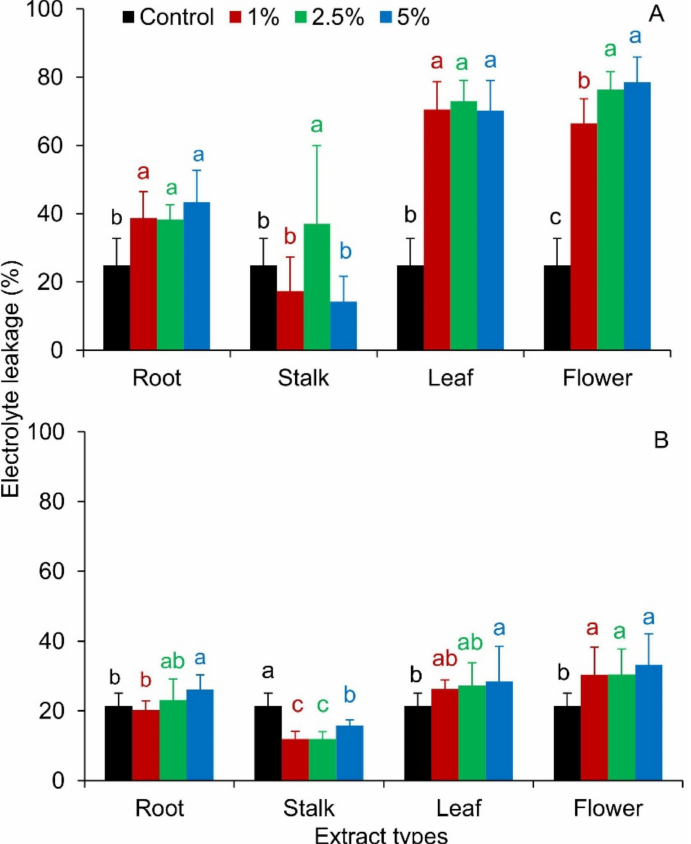
Figure 6. Electrolyte leakage from seedlings of Festuca rubra L. ( A ) and Raphanus sativus L. var. radicula Pers. cv. Rowa ( B ) treated with aqueous extracts from the organs of Rosa blanda Aiton with various concentrations (1%, 2.5%, 5%); the mean values of the three replicates ( n = 10, ± SD) marked with different letters are significantly different according to Duncan’s test p ≤